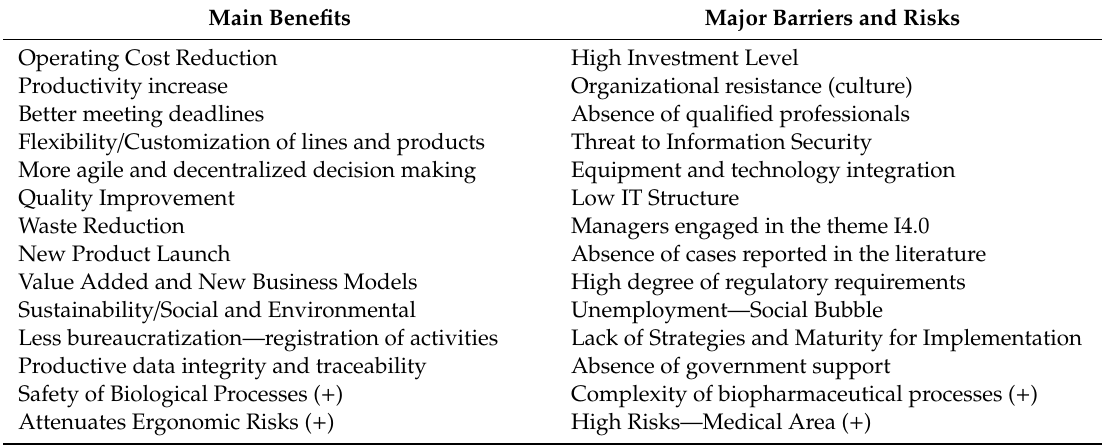
Table 2. Main benefits, barriers, and risks associated with I4.0, derived from the literature and added from insights collected in the field study (in the table with the +